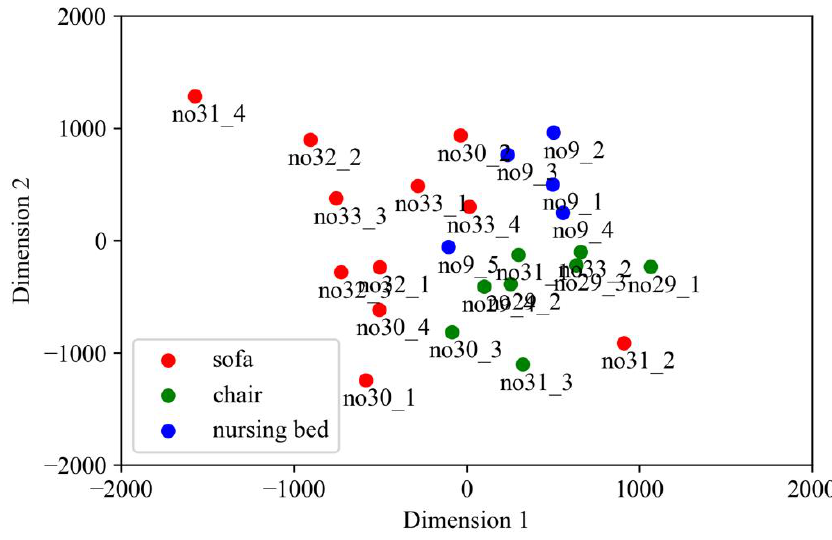
Figure 7. Standing behavior map categorized by products